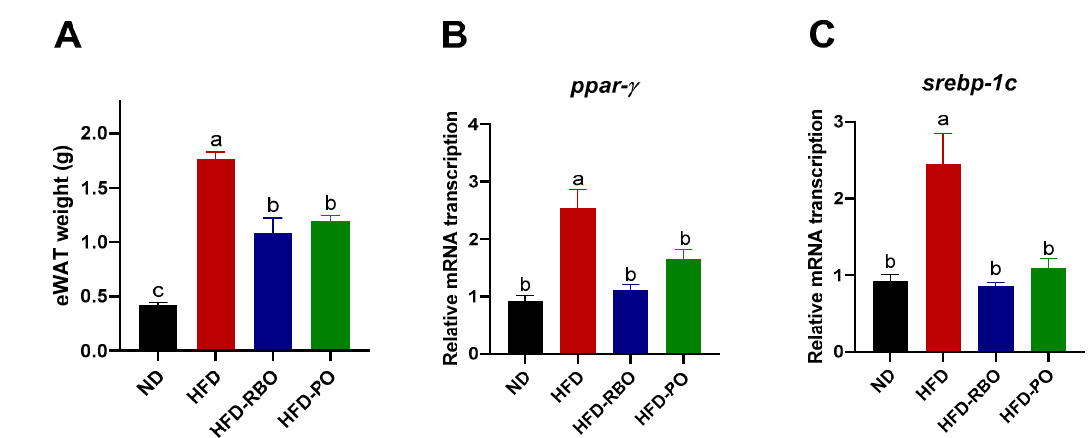
Figure 2. Epididymal white adipose tissue (eWAT) weights and expression of adipogenic genes. ( A ) Epididymal white adipose tissue was dissected and its weight measured after 10 weeks of dietary intervention. The expression of adipogenic genes, ( B ) ppar- γ and ( C ) srebp-1c , was assessed by qRT-PCR. Relative transcription levels of the target gene were calculated by normalization to β -actin using the delta–delta Ct method (2 − ∆∆ Ct ). Data are expressed as means ± SEM. Different letters indicate significant differences between groups ( p < 0.05) (ND, normal diet; HFD, high fat diet; HFD-RBO, high-fat diet-rice bran oil; HFD-PO, high-fat diet-palm oil).